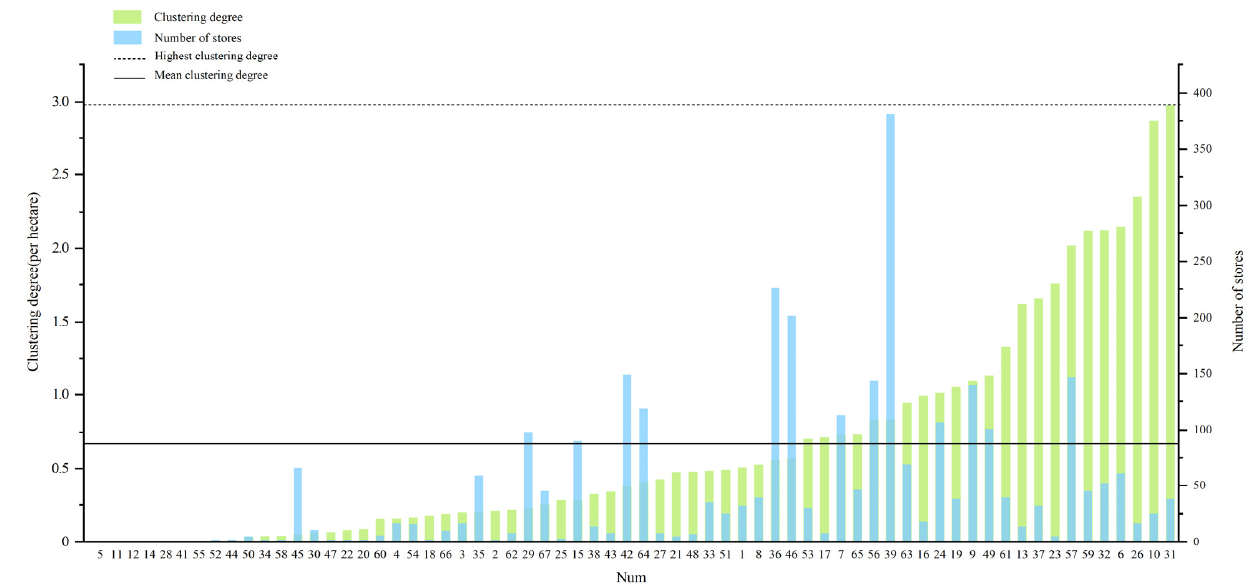
Figure 4. The clustering degree of children’s business formats and the number of stores in the sample business centers. Data sources: the field investigation data.